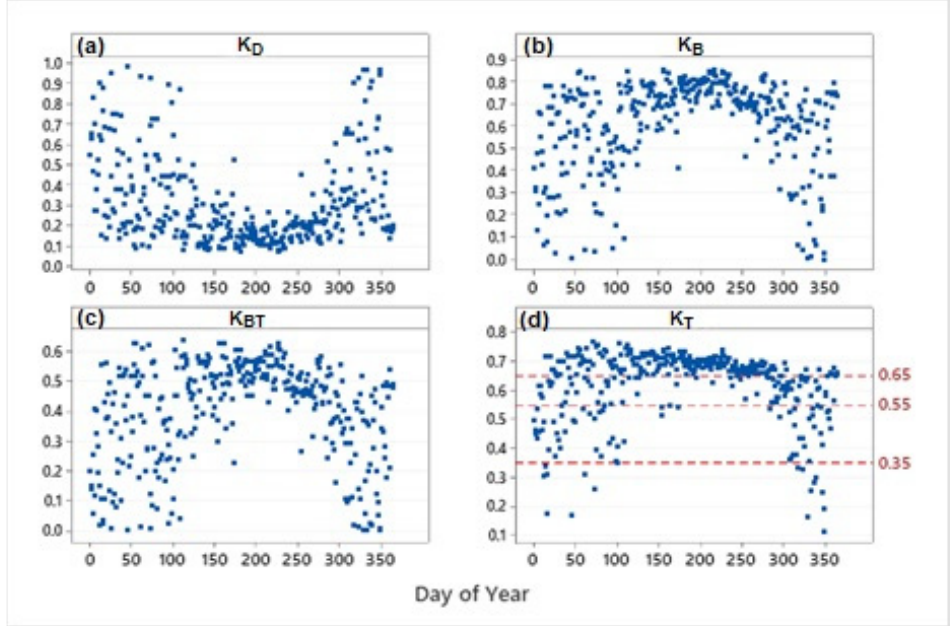
Figure 26. Daily values of radiation indices: ( a ) diffuse fraction ( K D ); ( b ) direct horizontal fraction ( K B ); ( c ) direct clearness index ( K BT ); and ( d ) clearness index ( K T ), throughout the year.